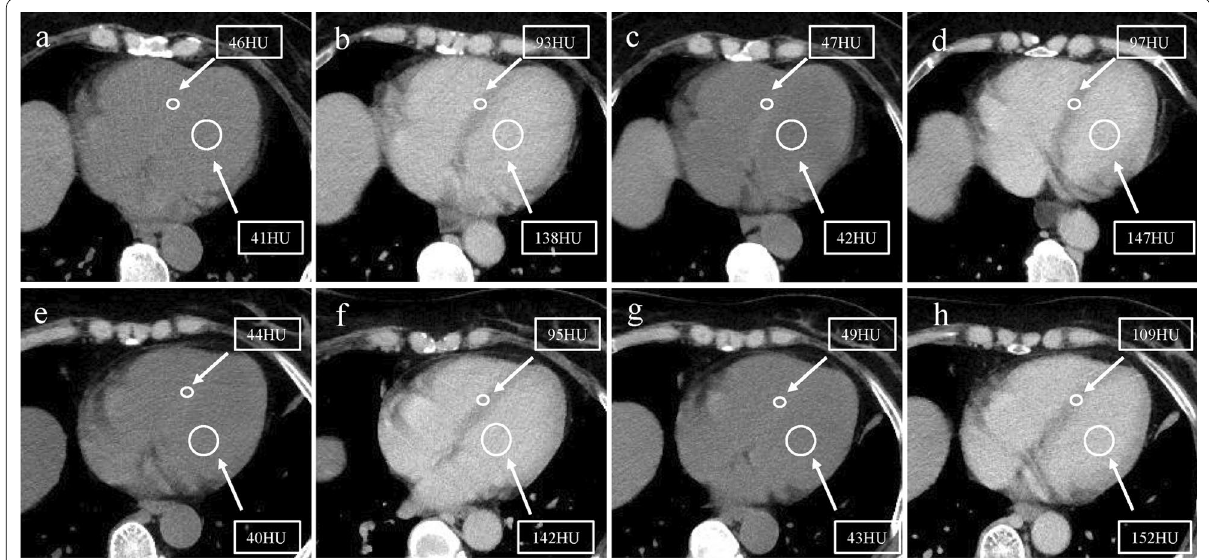
Fig. 4 A 48-year-old BC patient without CTRCD ( a , b , c , d ) and a 52-year-old BC patient with CTRCD ( e , f , g , h ). The baseline ECV value before anthracycline chemotherapy in patient without CTRCD was 29.56% derived from unenhanced ( a ) and enhanced CT images ( b ). The ECV value after completing anthracycline chemotherapy was 30.00% derived from unenhanced ( c ) and enhanced CT images ( d ). The baseline ECV value before anthracycline chemotherapy in patient with CTRCD was 29.50% derived from unenhanced ( e ) and enhanced CT images ( f ). The ECV value after completing anthracycline chemotherapy was 34.68% derived from unenhanced ( g ) and enhanced CT images ( h ). BC , breast cancer; CTRCD , cancer therapy-related cardiac dysfunction; ECV , myocardial extracellular volume; CT , computed